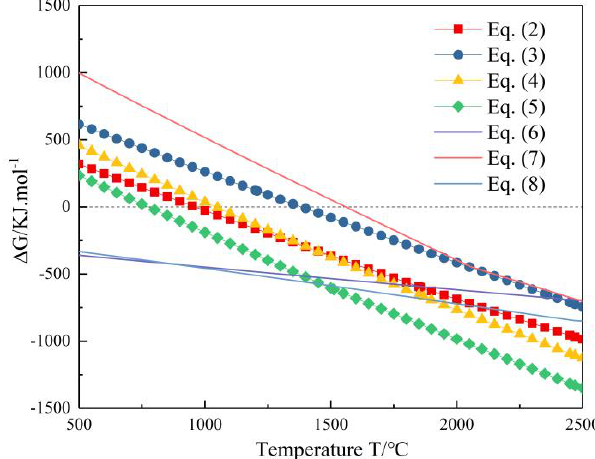
Figure 1. Gibbs free energy changes for each reaction as a function of temperature.